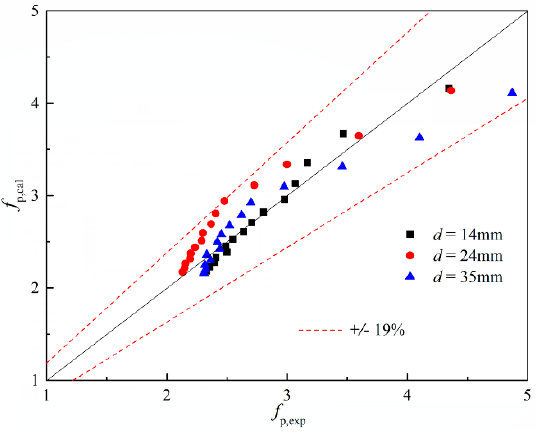
Figure 6. Comparison between the experimental values and the calculation values based on Equa- tion (15).